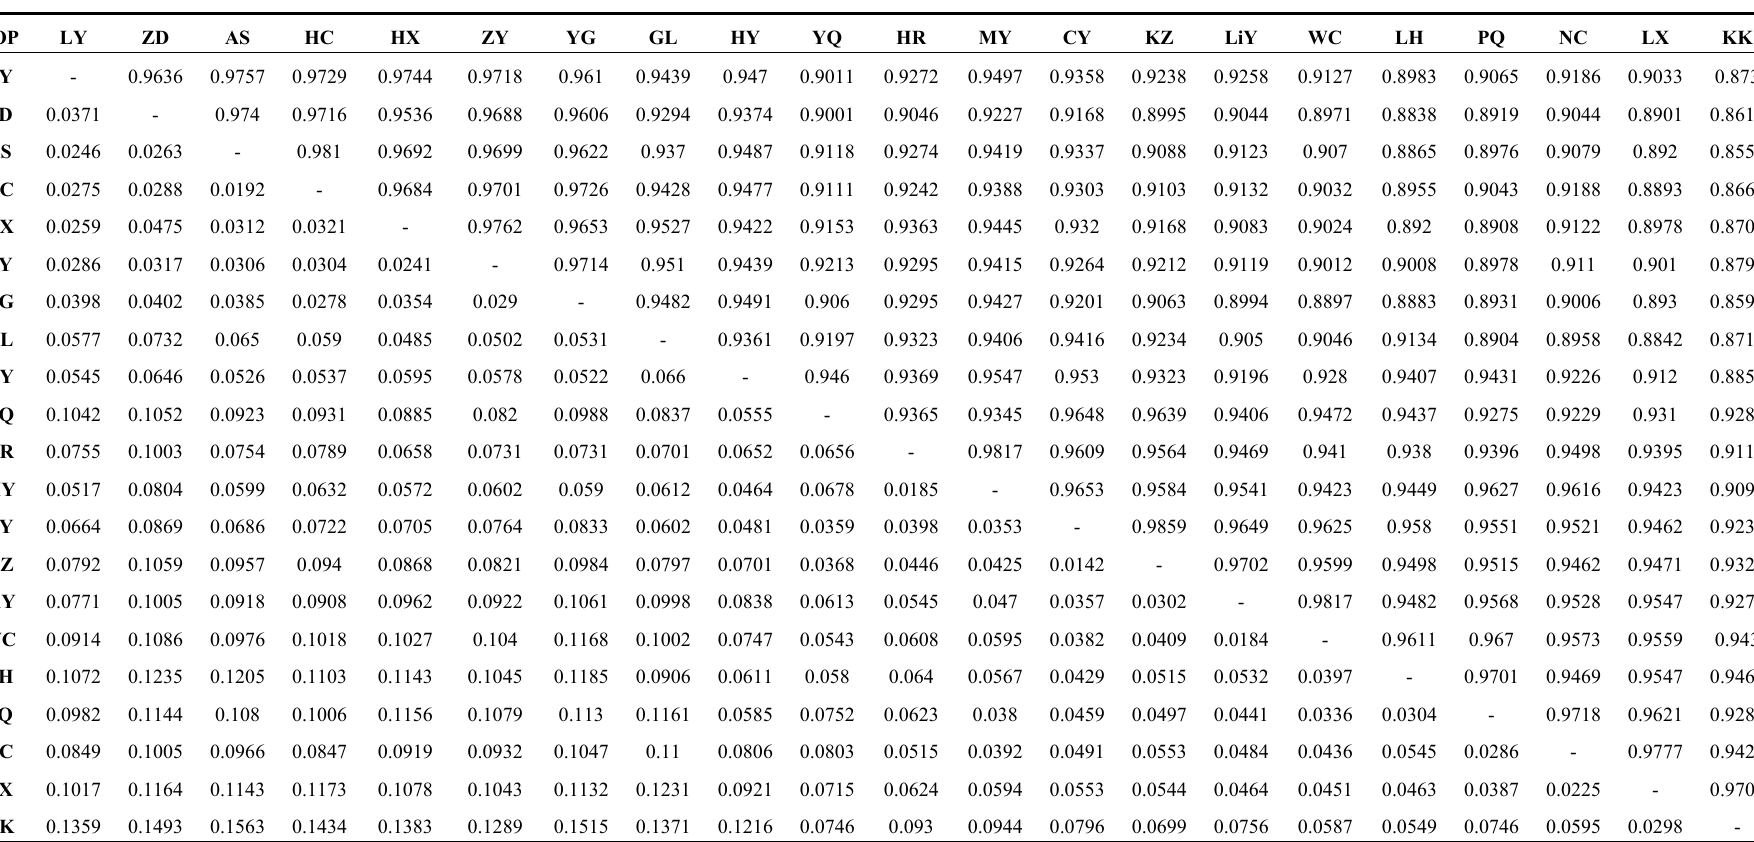
Table S4. Nei’s (1978) unbiased genetic identity (above diagonal) and genetic distance (below diagonal) among Siberia apricot populations reveled by SRAP markers